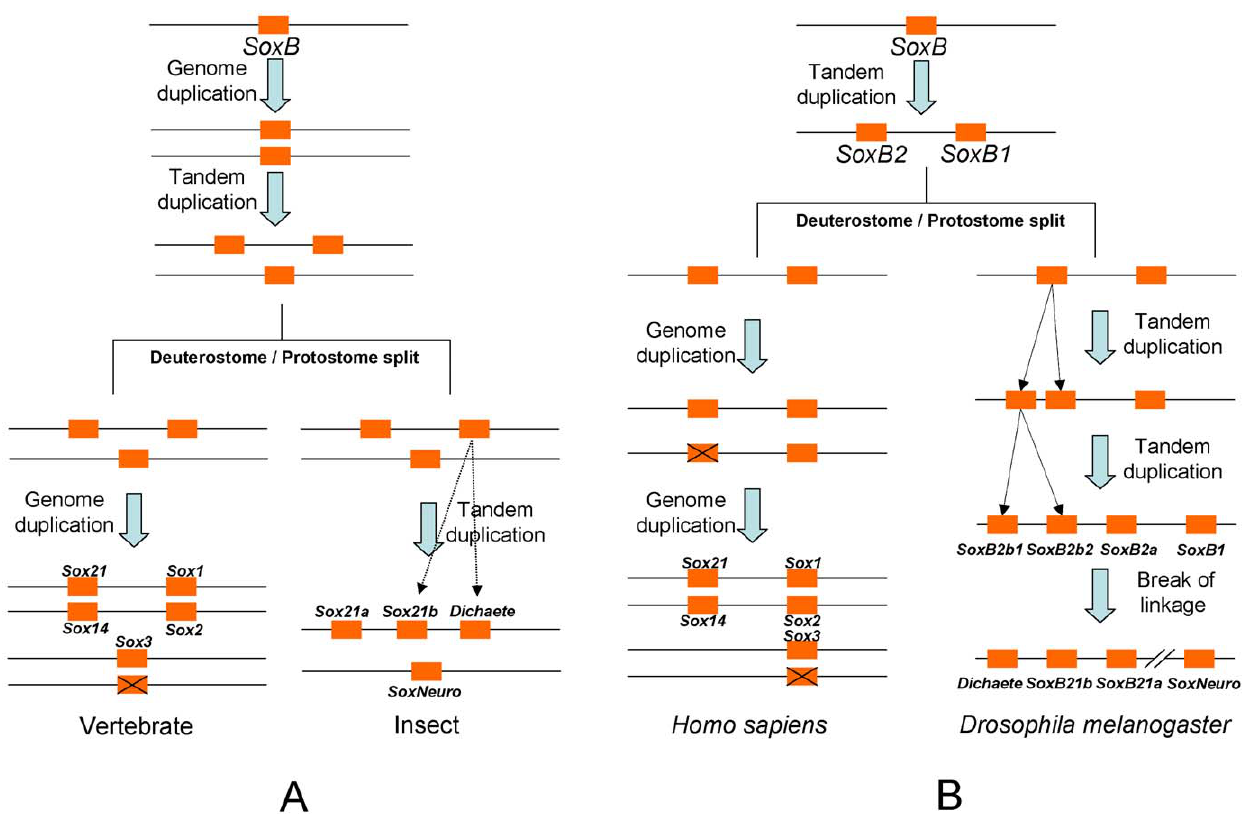
Figure 8. Comparison of the two models of Sox group B evolution. (A) The model for Sox group B evolution proposed by McKimmie et al . (2005) [26]. In this model, an ancestral SoxB generate original Dichaete and SoxNeuro by an ancient genome duplication, a subsequent tandem duplication generate original Sox21a before the Deuterostome/Protostome split. After the Deuterostome/Protostome split, a further tandem duplication generated Sox21b in insects and an independent genome duplication event increased the copy number of SoxB in vertebrates. (B) The model for Sox group B evolution proposed in this study. In this model, the Protostome–Deuterostome LCA had one SoxB1 and one SoxB2 generated by an ancient tandem duplication of an ancestral SoxB . After the Deuterostome/Protostome split, two further tandem duplications gave rise to the additional two copies of SoxB2 in arthropods, and a linkage break between SoxB1 and SoxB2 s occurred in the ancestor of Drosophila , resulting in the different chromosome locations of SoxB1 and SoxB2 s in Drosophila ; independently, the vertebrates increased their copy number of SoxB through the two rounds of genome duplication. Forks on the rectangles indicate pseudogenization leading to gene loss. SoxB2b1 , SoxB2b2 , and SoxB2a are the preferred synonyms for Dichaete , Sox21a , and Sox21b , respectively. Sry is currently considered to have evolved from allele Sox3 on the Y chromosome [69], and is therefore not shown in the models.